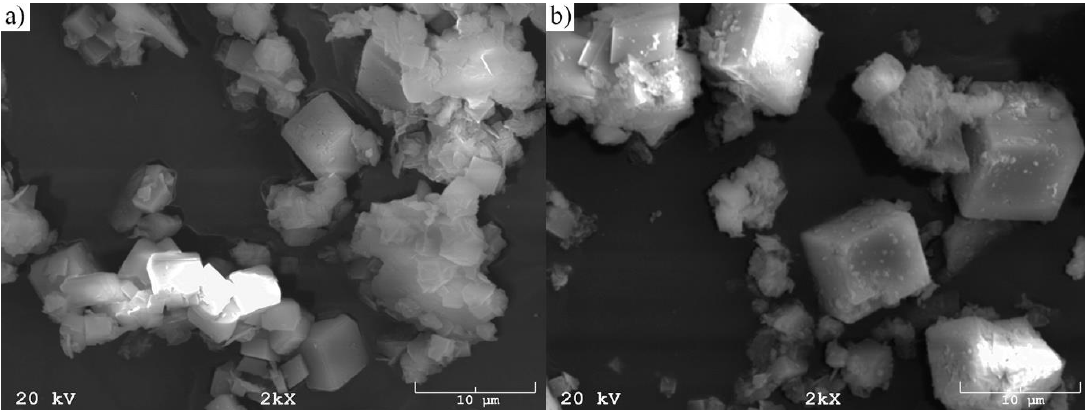
Figure 6. The SEM morphology of produced coal shale synthesis: ( a ) S1 and ( b ) S2.